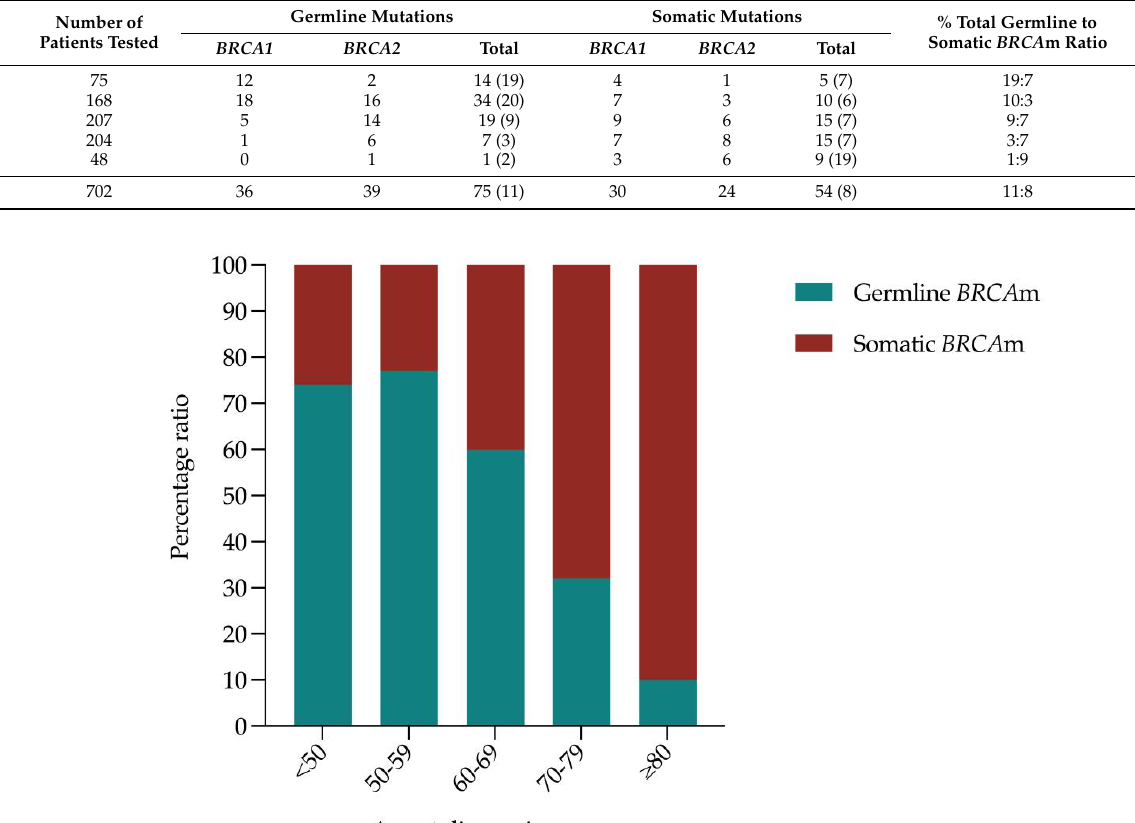
Table 3. Demographic data for patients that were tested using Myriad’s myChoice ® CDx. Data are presented as mean (range) or number (percentage; the denominator being the ‘Total’). Key: BRCA m, BRCA1/2 pathogenic variant; BRCA wt, BRCA1/2 wild type; GIS-, GIS-negative; GIS+, GIS-positive; NOS, not otherwise specified. The four BRCA m/GIS- tumors included germline BRCA2 Exon 14-16 deletion (GIS 36), somatic BRCA1 Exon 13-24 deletion (GIS 34), somatic BRCA2 c.9097dup (GIS 5) and somatic BRCA2 c.3760G>T (GIS 24). Demographic